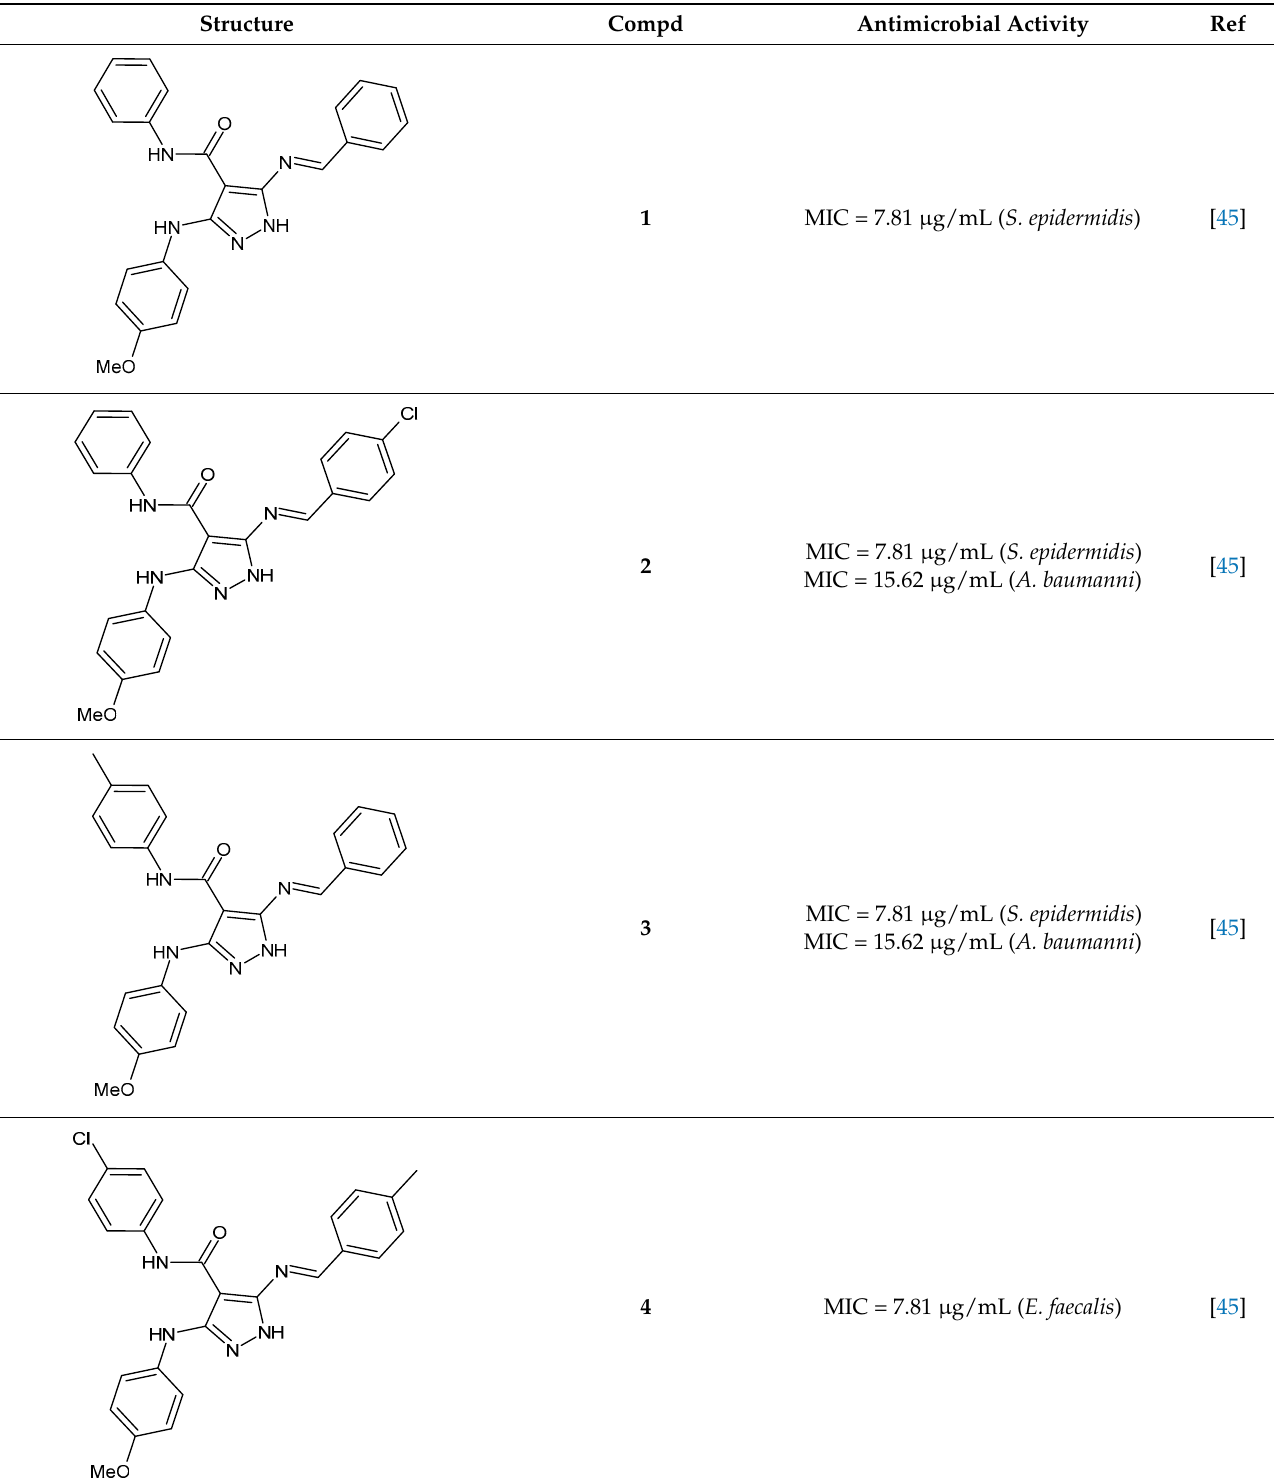
Table 1. Schiff bases with antibacterial activity.